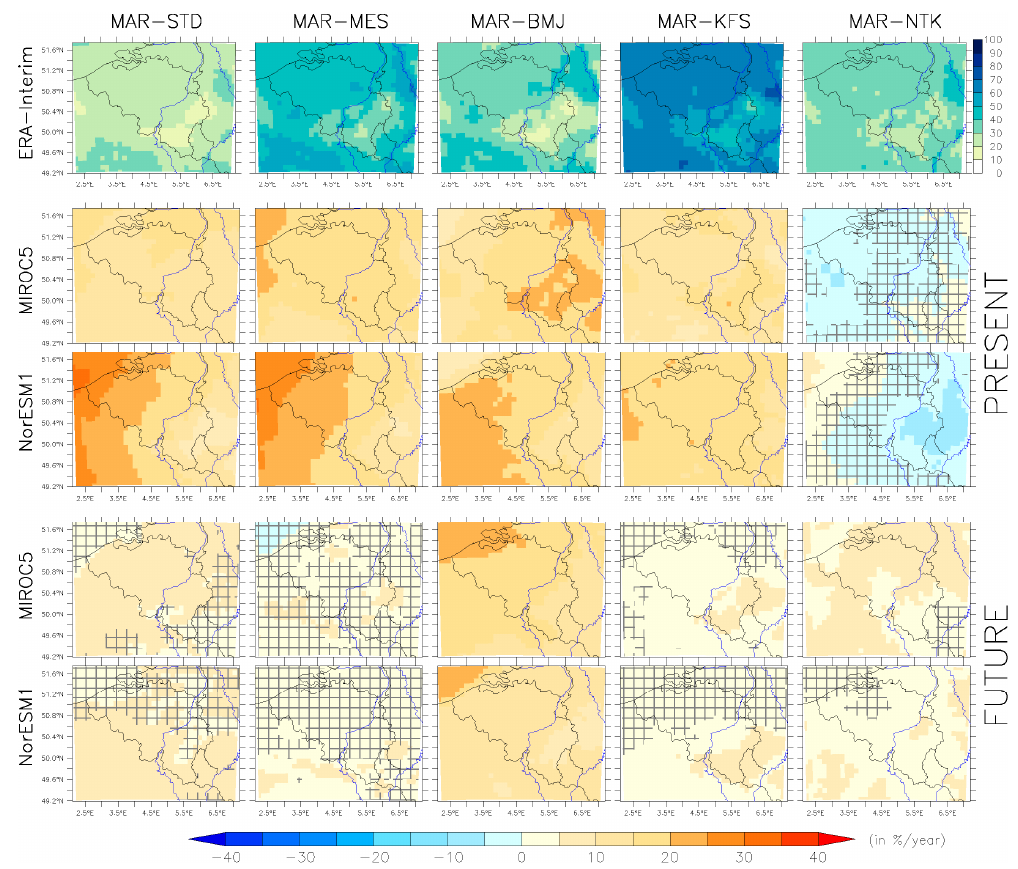
Figure 4. Same as Figure 2, but for the ratio between convective precipitation and total precipitation in %/year.